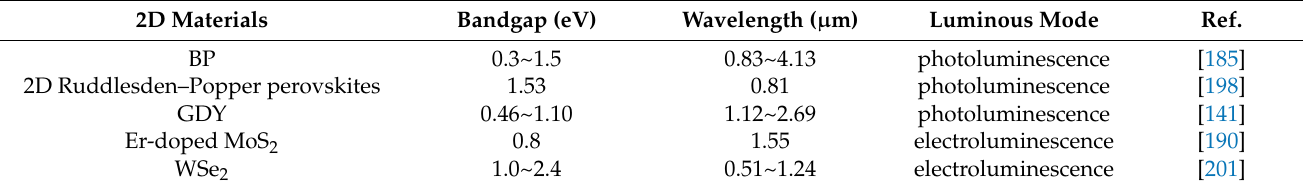
Table 2. The 2D material candidates for LEDs